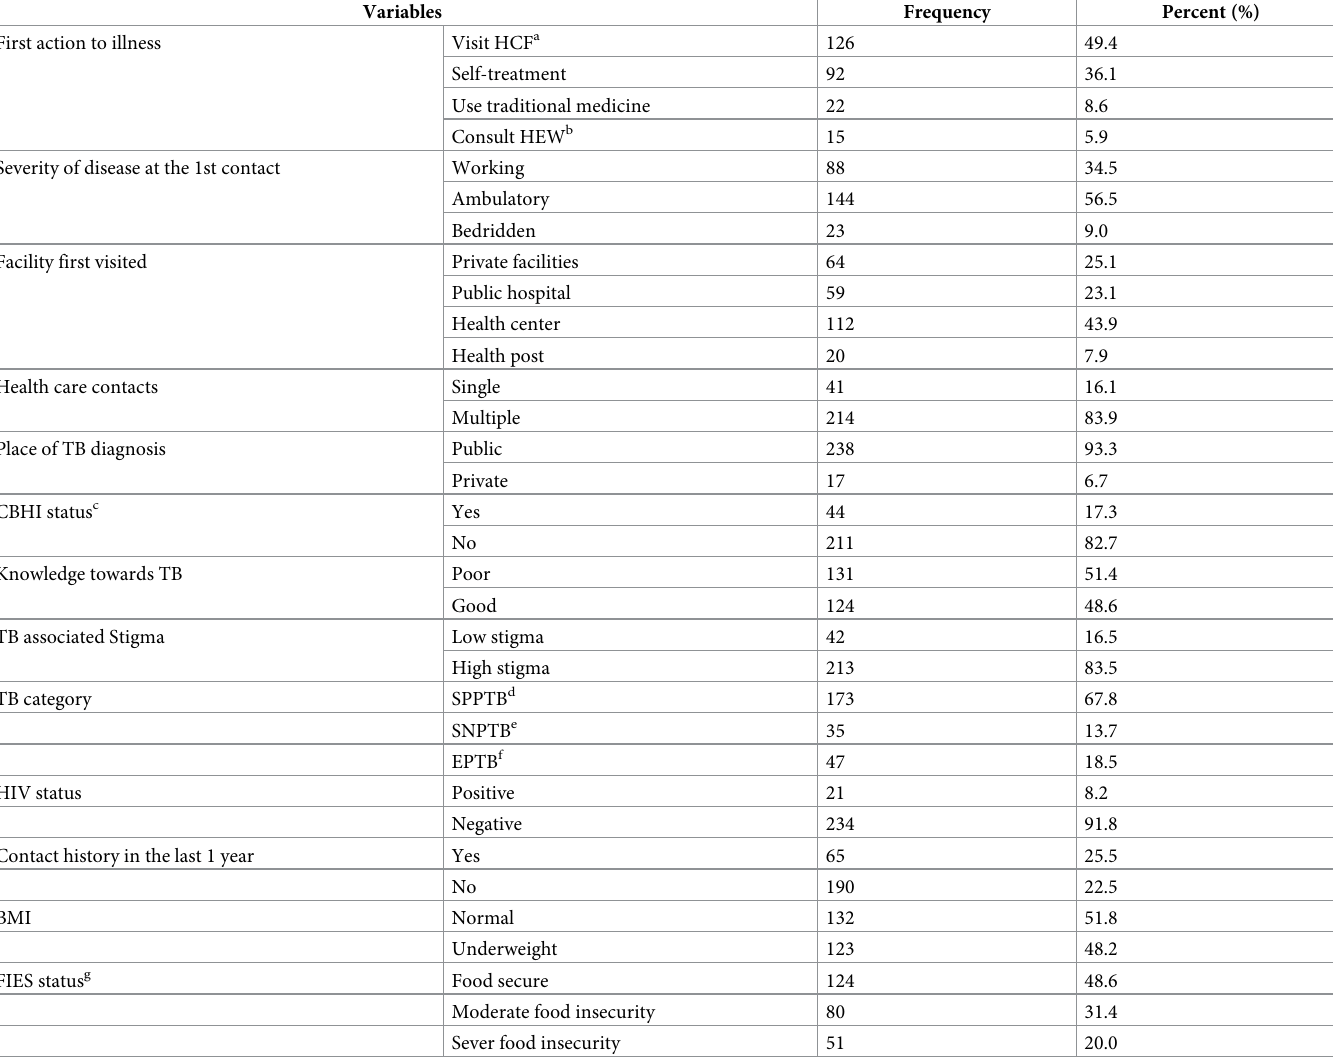
Table 2. Healthcare seeking behavior among TB patients in Gamo zone public health facilities, Southern Ethiopia, 2019 (n =